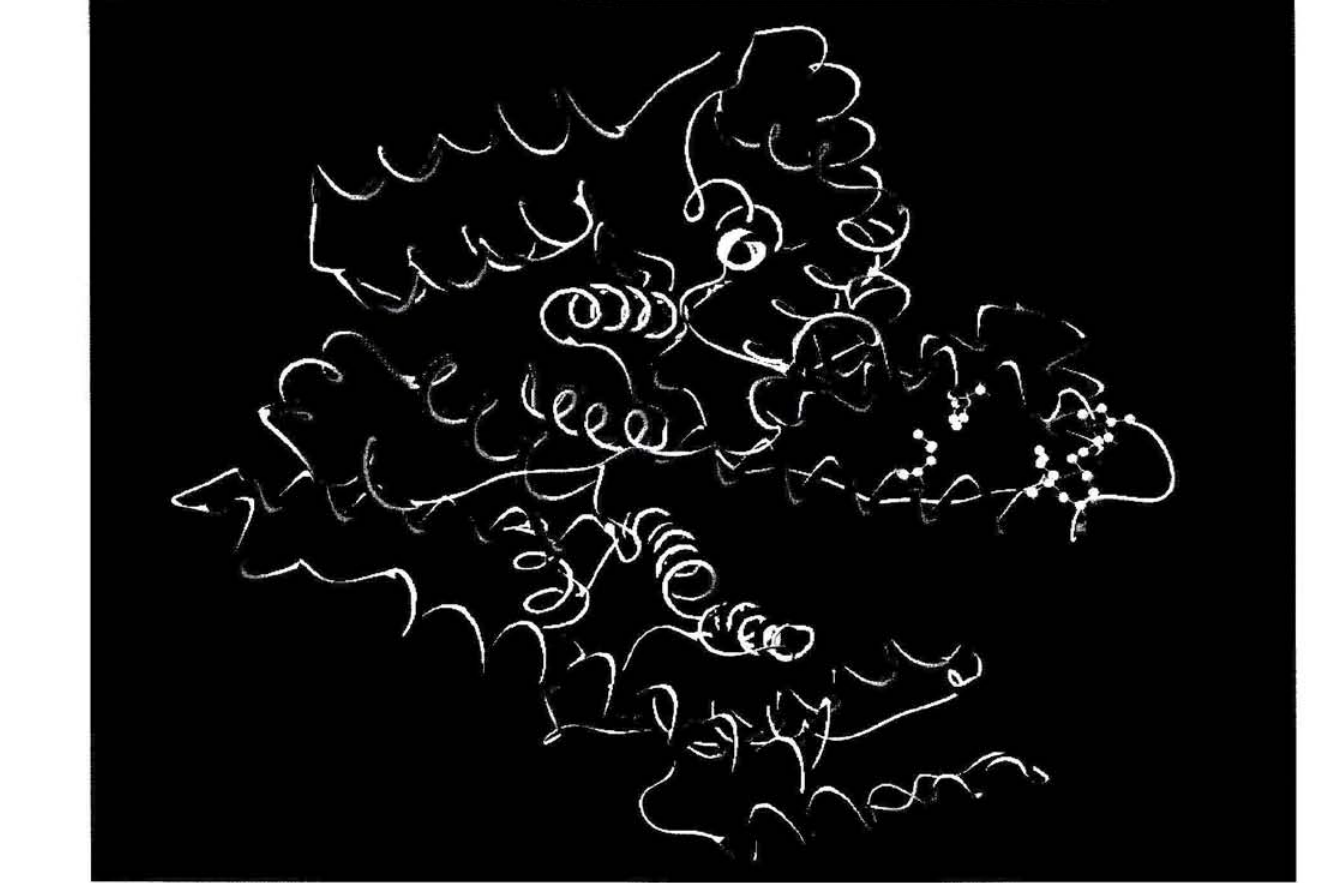
Figure 3. Tertiary structure of human serum albumin. The folding of the protein is visualized as backbone ribbon showing secondary structure elements, whereas the active site is represented as atomic ball-and-stick model. The biological significant sequence pattern for albumin results from the PROSITH database and was identified and visualized on the 3D